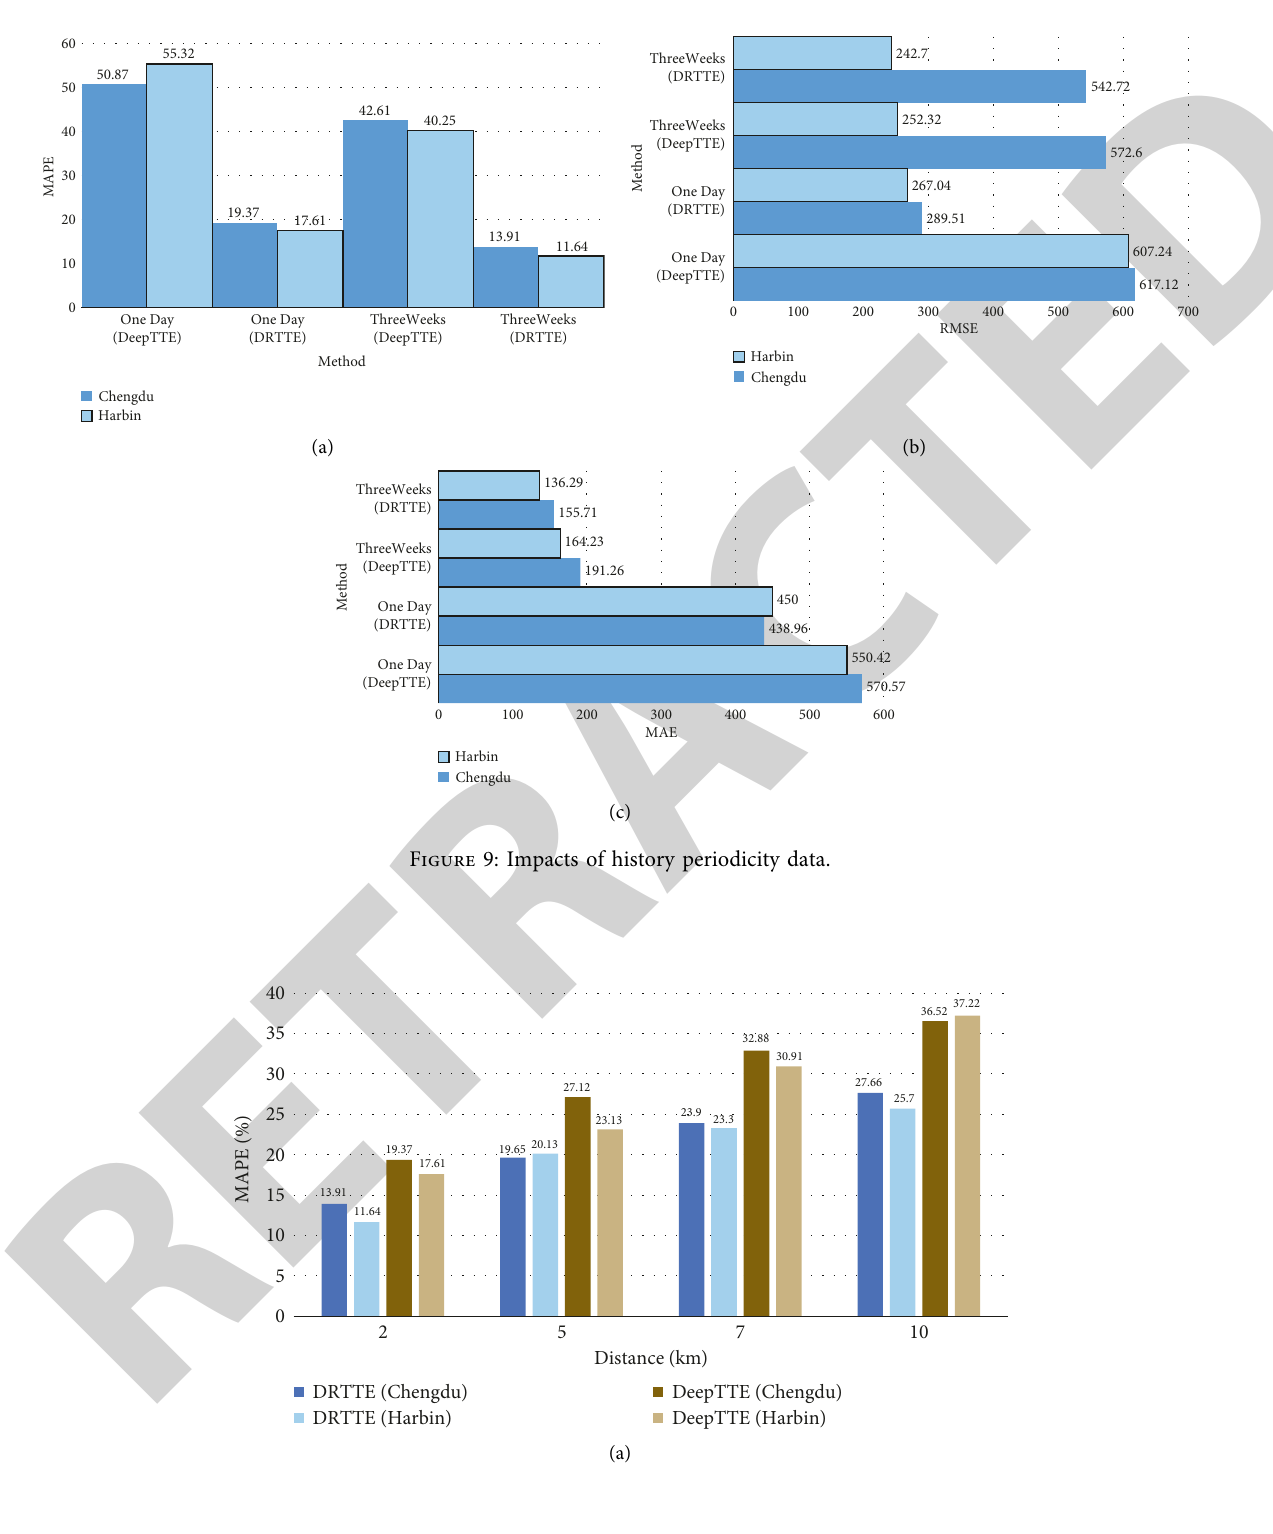
Figure 9: Impacts of history periodicity